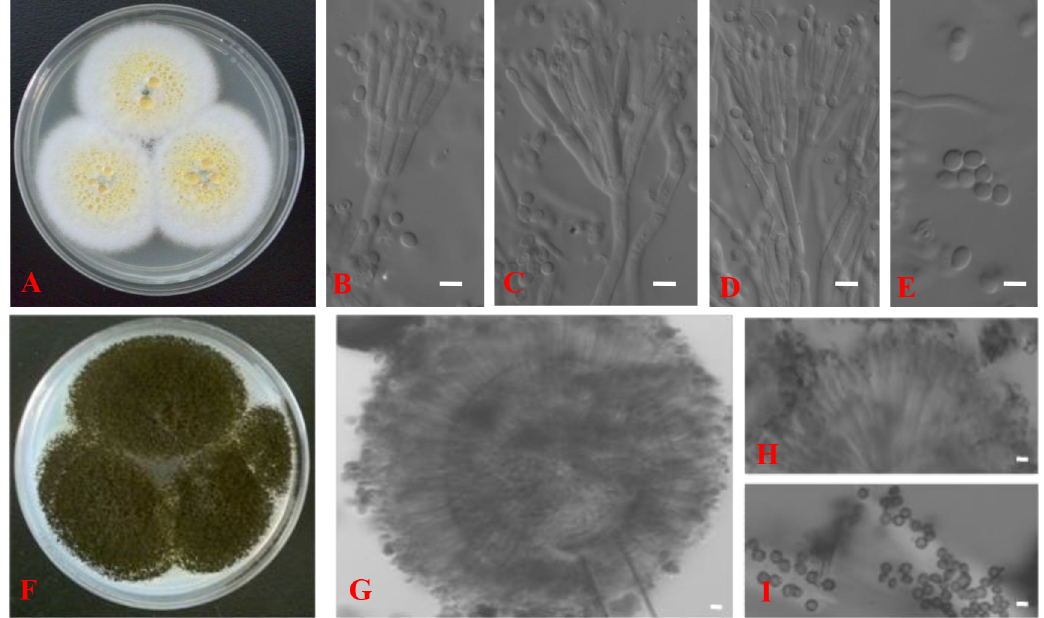
Fig 2. Talaromyces aurantiacus (TalA-JX04): Colonies on CYA at 25˚C after 7 days (A), Conidiophores, phialides and conidia (B– D); Conidia (E); Aspergillus neoniger (AspN-JX16): Colonies on CYA at 25˚C after 7 days (F), Head of conidiophore, phialides, and conidia (G); Double spore production cells (H); Conidia (I). Scale bars = 5 μ